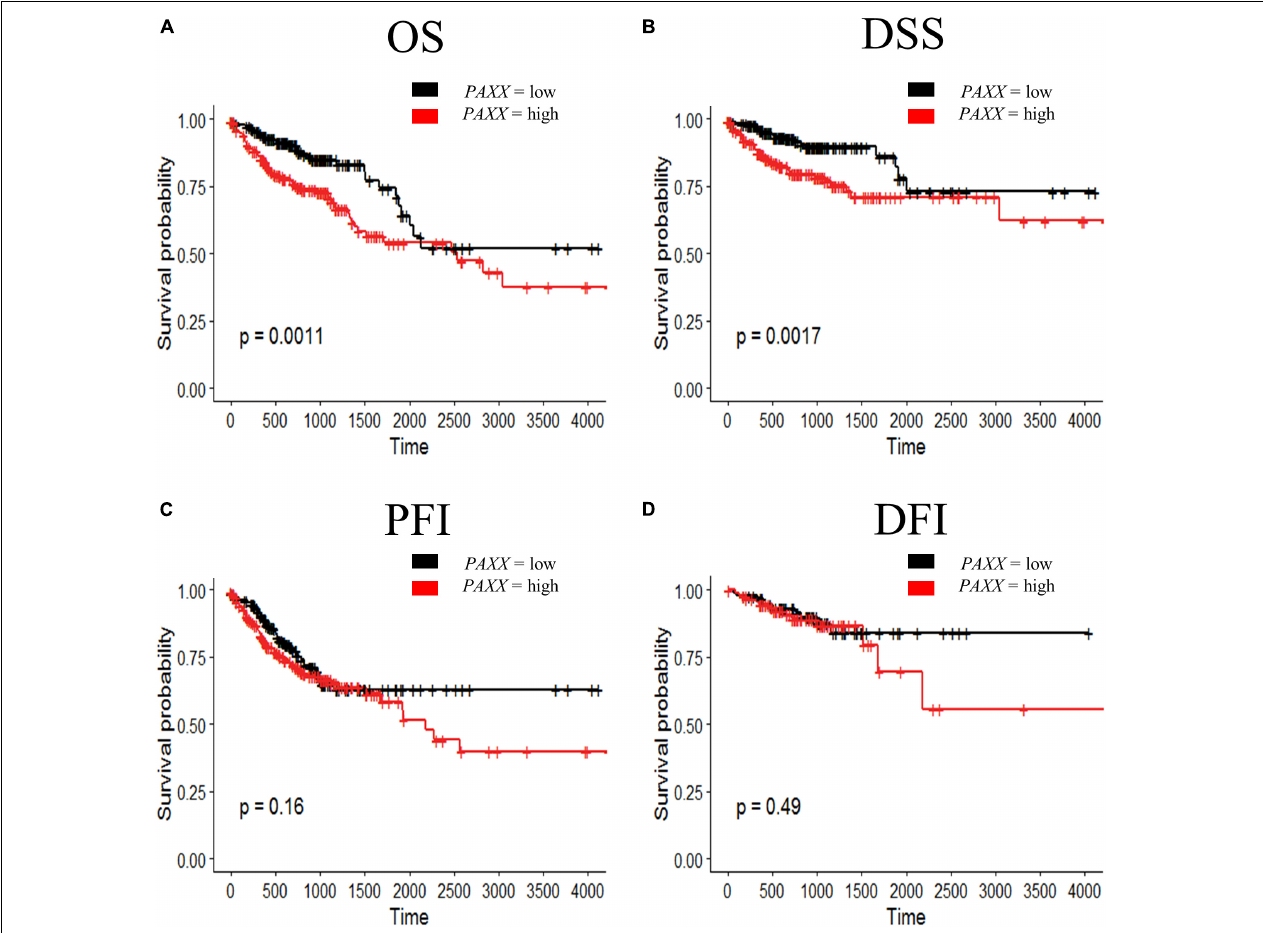
FIGURE 6 | Kaplan-Meier survival curve for prognostic significance of PAXX gene expression in TCGA-COAD dataset, including (A) overall survival (OS), (B) disease-specific survival (DSS), (C) progression-free interval (PFI), and (D) disease-free interval (DFI). Survival probabilities are presented on the y -axis and time in days on the x -axis in all graphs. The log-rank test p -value has been depicted in respective graphs.